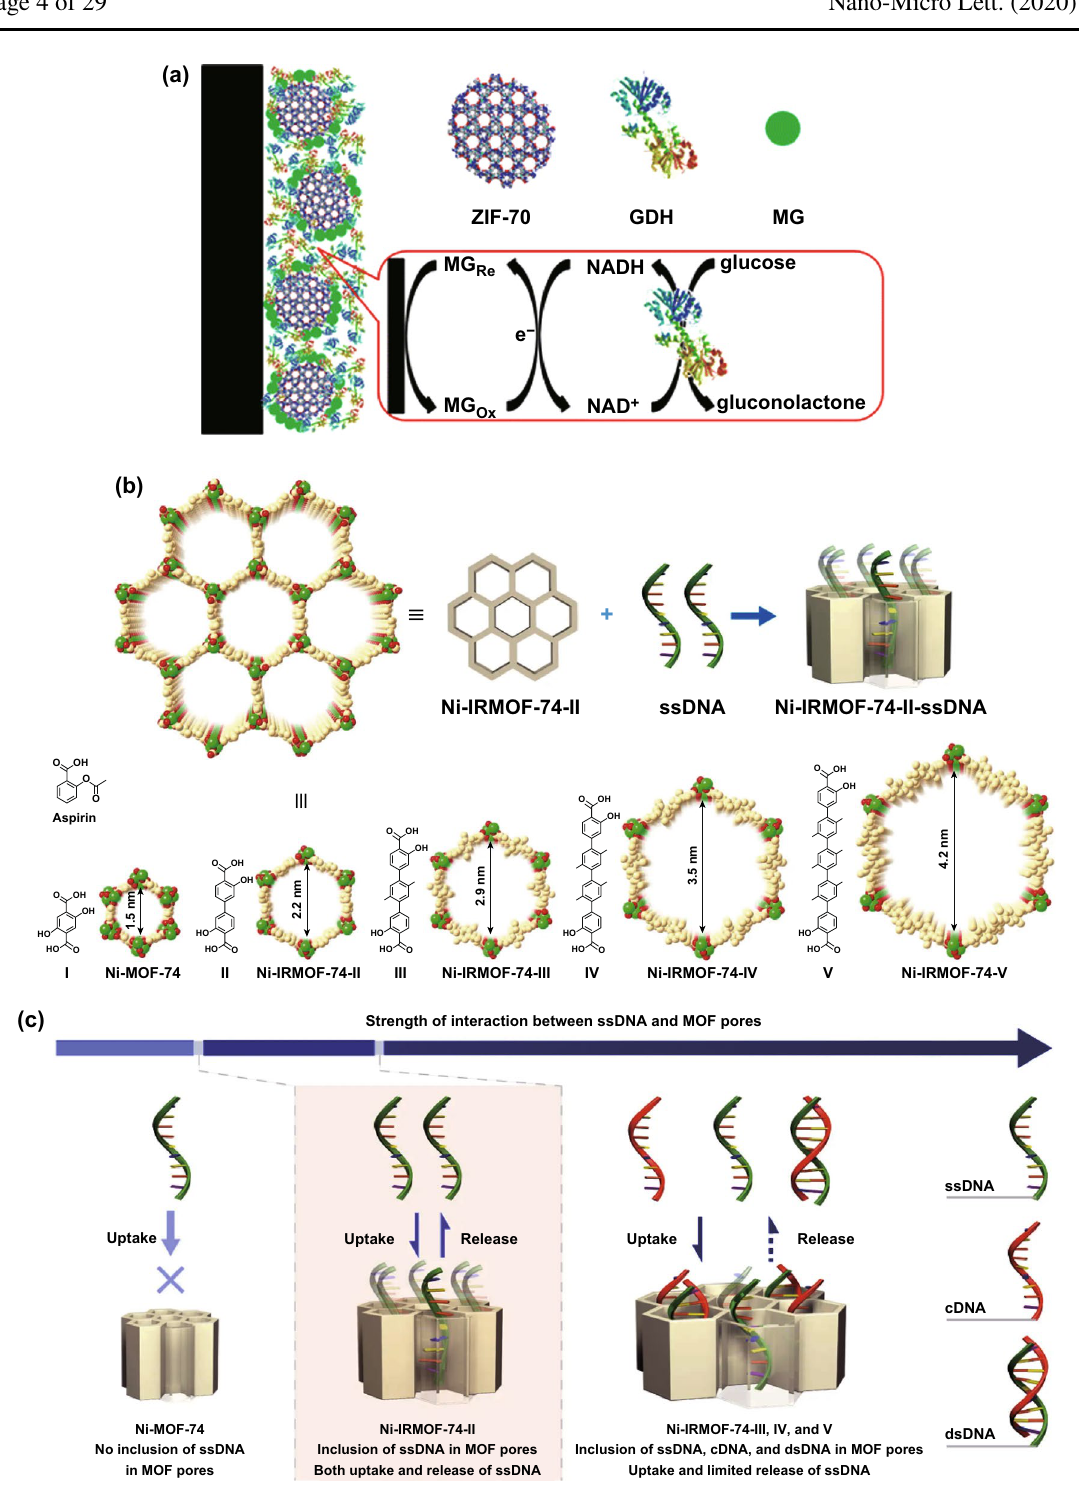
Fig. 1 a Schematic illustration of fabricating an integrated electrochemical biosensor for glucose using ZIF-70 as the matrix to co-immobilize MG and GDH onto the surface of electrode. Reproduced with permission from Ref. [51]. Copyright 2013, American Chemical Society. b Sche- matic illustration of ssDNA immobilization in Ni-IRMOF-74 series with precisely controlled channel size. Ni, C, and O atoms were labeled with green, gold, and red color, respectively. c Gradual increase in the interaction between ssDNA and MOFs with the increase in MOF channel size. Relatively weak interactions ensured the uptake, protection, and reversible release of ssDNA. Reproduced with permission from Ref. [53]. Copy- right 2018, Nature Publishing